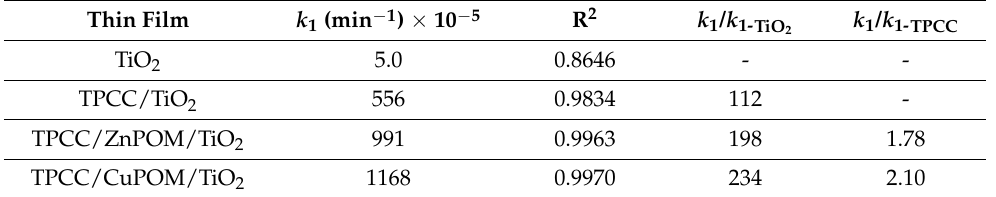
Table 5. Fitting results of Langmuir–Hinshelwood for the photocatalytic degradation of MB under visible irradiation